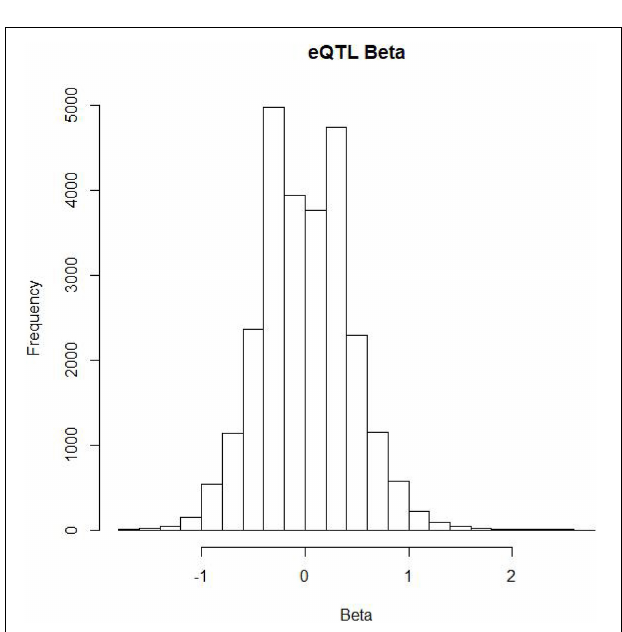
FIGURE 2 | The distribution of eQTL beta on lung